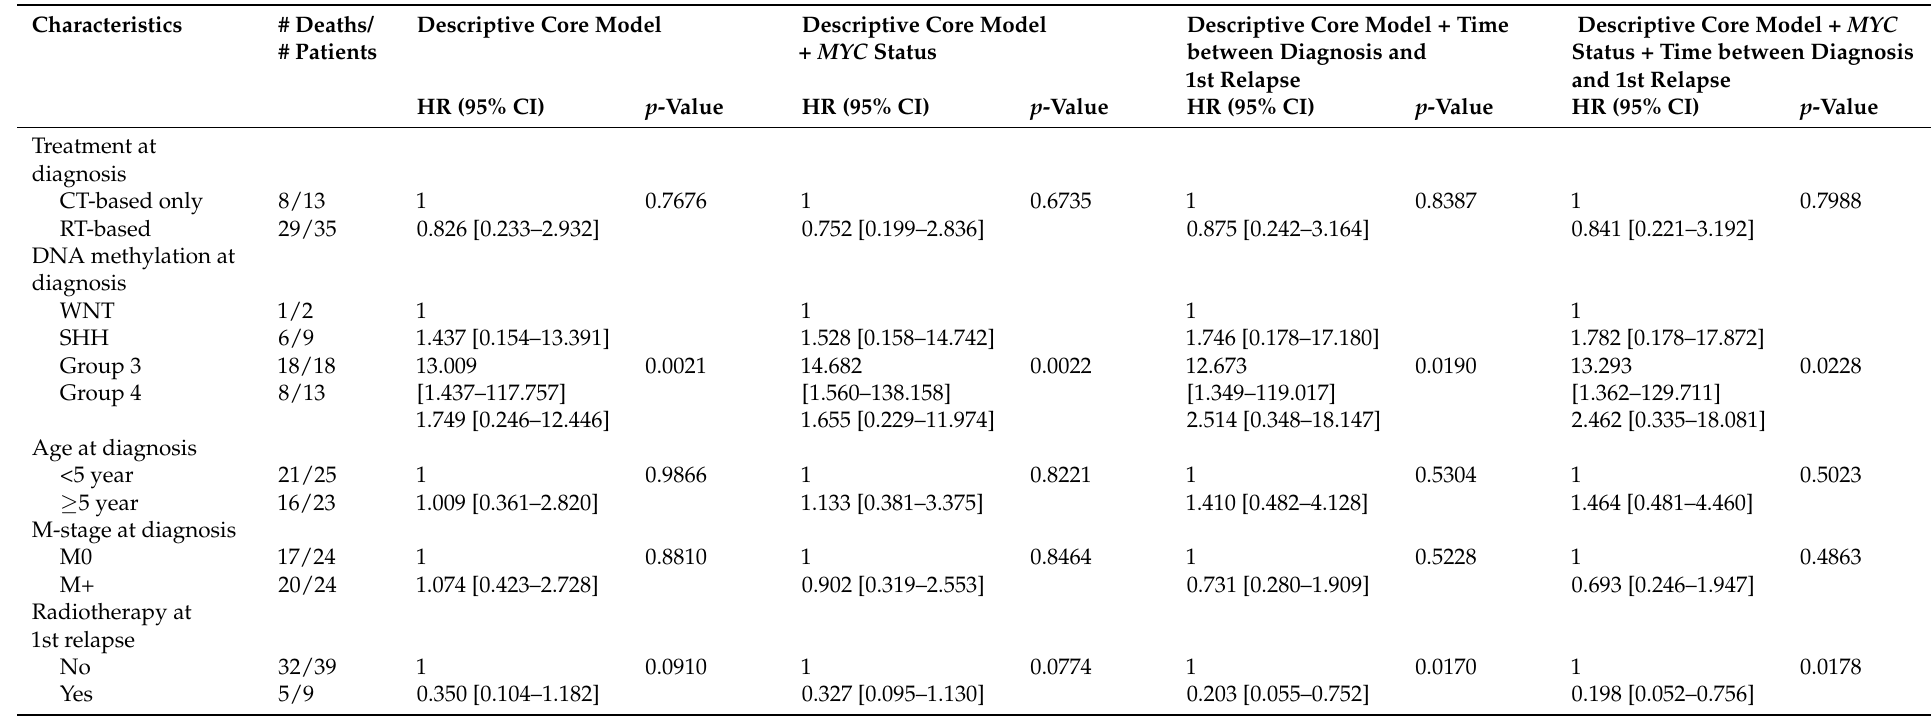
Table 2. Penalized (Firth’s approach) full Cox regression analysis for overall survival post recurrence ( n = 48, 37 deaths) (origin time is the date of first progression/relapse) † ,*.